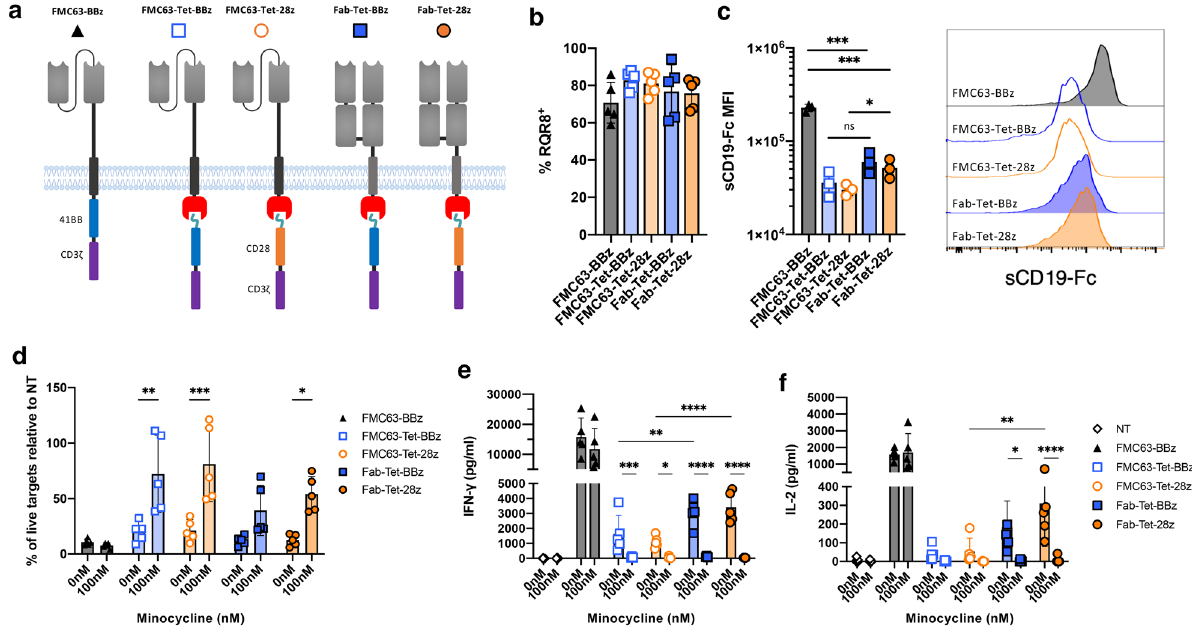
Figure 2. Optimization of TetCAR surface expression and signaling. ( a ) Schematic overview of TetCAR constructs containing 41BB-ζ or CD28-ζ endodomains. Antigen recognition is provided by the FMC63 scFv or Fab fragment. ( b ) Transduction efficiency as measured by CD34 staining of the RQR8 marker gene. Data shows mean ± SD, n = 5 donors from 2 independent experiments. ( c ) Median fluorescent intensity (left) and representative histograms (right) of CAR expression on surface of RQR8 + cells as measured by staining with soluble, Fc-tagged CD19 protein. Data shows mean ± SD, n = 3 donors from 1 experiment. Unpaired T tests were used for statistical analysis. P values = FMC63-BBz versus Fab-Tet-BBz (***, 0.0003) or Fab-Tet-28z (***, 0.0002), was added to relevant wells. Data shows mean percentage (± SD) of live cells compared to non-transduced (NT) control, n = 5 donors from 2 independent experiments. Statistical analysis was through a two-way ANOVA with Šidák’s multiple comparisons within each group ± minocycline. P values for each construct + /- minocycline were: FMC63-Tet-BBz (**, 0.0023), FMC63-Tet-28z (***, 0.0003) and Fab-Tet-28z (*, 0.0279). ( e ) IFN-γ and ( f ) IL-2 release after 24 h of co-culture with SupT1-CD19-GFP at 1:1 E:T ratio. Data shows mean ± SD, n = 5 donors from 2 independent experiments. Statistical analysis was through two-way ANOVAs between the TetCAR groups at 0 nM minocycline (with Tukey’s multiple comparisons) or within these groups ± minocycline (with Šidák’s multiple comparisons). P values were; between FMC63-Tet-BBz and Fab-Tet-BBz (**, 0.0097, IFN-γ) and between FMC63-Tet-28z and Fab-Tet-28z (****, < 0.0001, IFN-γ and **, 0.0017, IL-2). P values between the TetCAR constructs ± minocycline were: FMC63-Tet-BBz (***, 0.0007, IFN-γ), FMC63-Tet-28z (*, 0.0409,